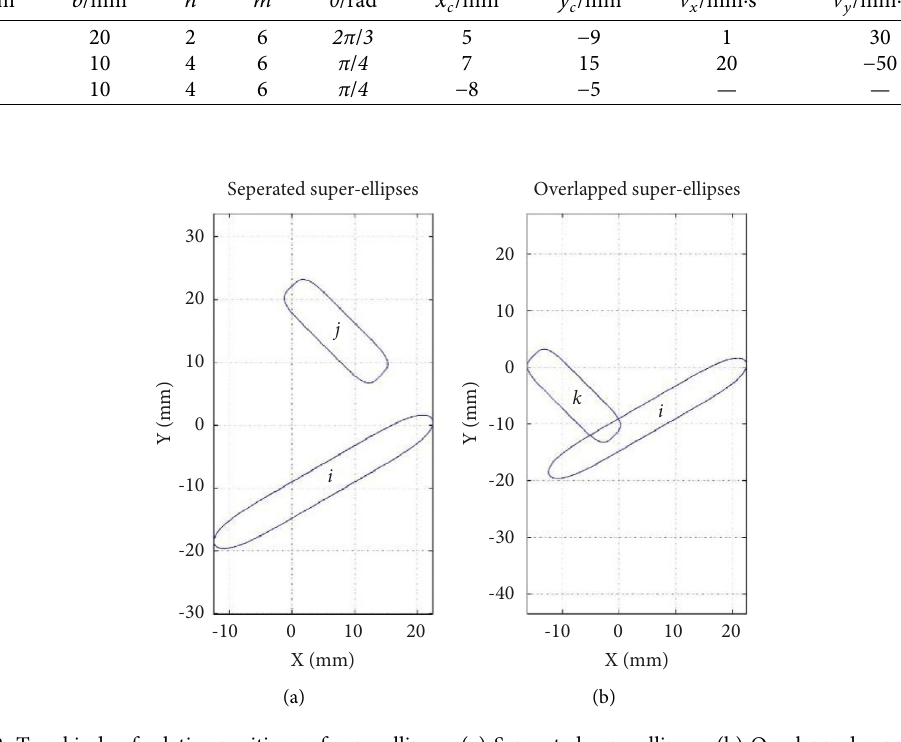
Figure 2: Two kinds of relative positions of superellipses. (a) Separated superellipses. (b) Overlapped